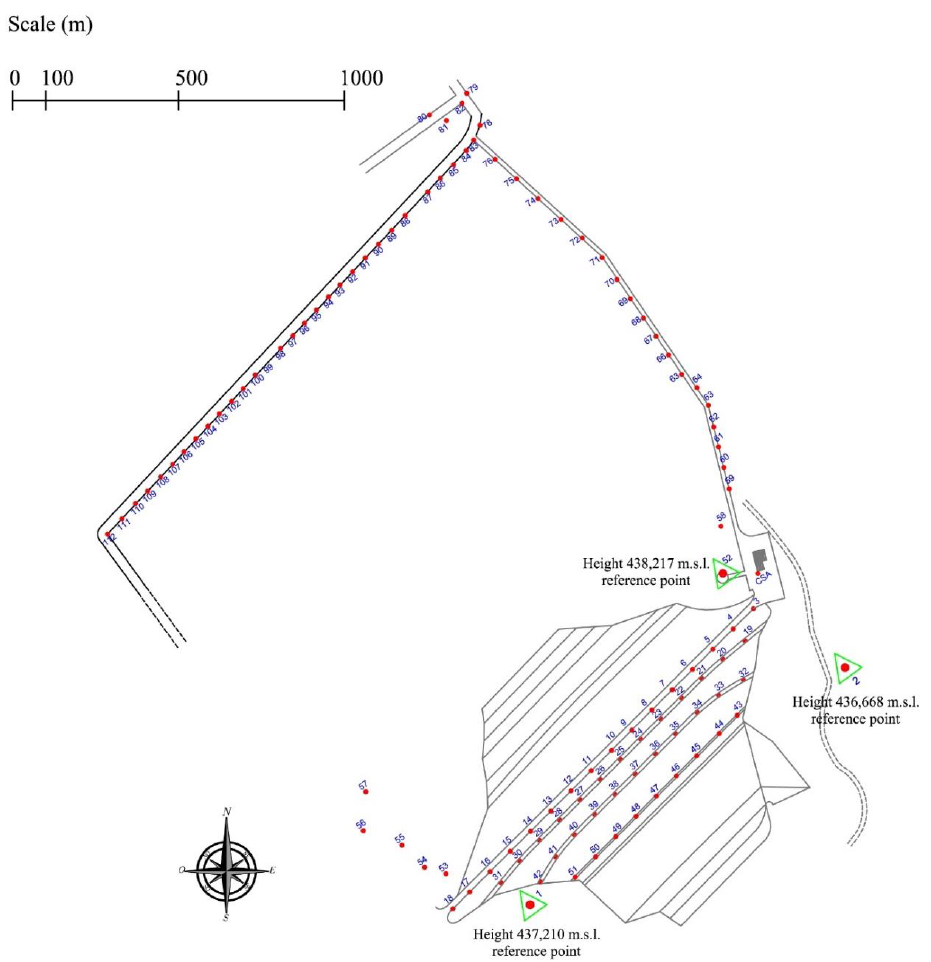
Figure 6. Levelling surveying: location of the benchmarks.